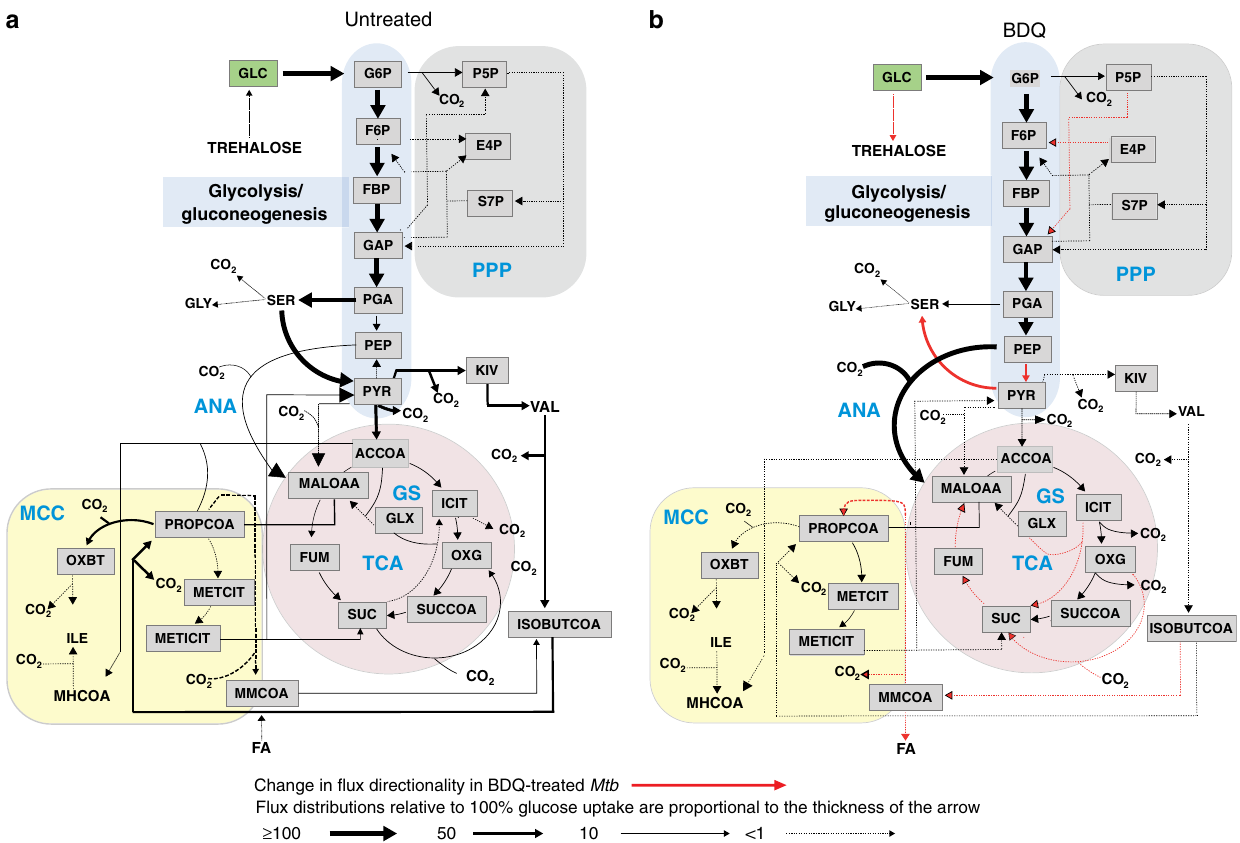
Fig. 7 BDQ treatment induces a change in fl ux directionality. Metabolic fl ux maps of ( a ) untreated and ( b ) BDQ-treated Mtb growing with glucose as the primary carbon source. The fl uxes shown are proportional to the glucose-uptake fl ux that is arbitrarily set to 100%. The fl uxes that are signi fi cantly changed in directionality are indicated by red arrows. G6P - glucose 6 phosphate, F6P - fructose-6 phosphate, FBP - fructose-1,6-bisphosphate, GAP - glyceraldehyde-3-phosphate, P5P - pentose 5 phosphate, E4P - erythrose 4 phosphate, S7P - sedoheptulose-7 phosphate, SER - serine, PGA - 3 phosphglyceric acid, PEP - phosphoenolpyruvate, PYR - pyruvate, KIV - 2 ketoisovalerate, VAL - valine, ACCOA - acetyl-CoA, ICIT - isocitrate, OXG - alpha-ketoglutarate, SUCCOA - succinyl CoA, ISOBUTCOA - isobutyrylCoA, SUC - succinate, FUM - fumarate, MALOAA - malate and oxaloacetate, PROPCOA - propionyl-CoA, METCIT - methylcitrate, METICIT - methylisocitrate, ILE - isoleucine, FA - fatty